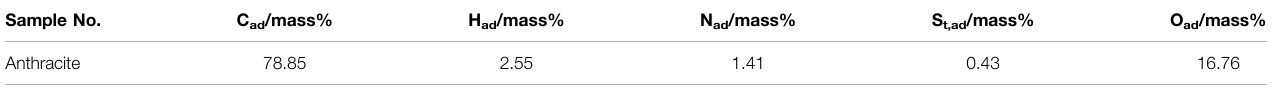
TABLE 2 | Ultimate analysis data of the coal sample. Sample No.